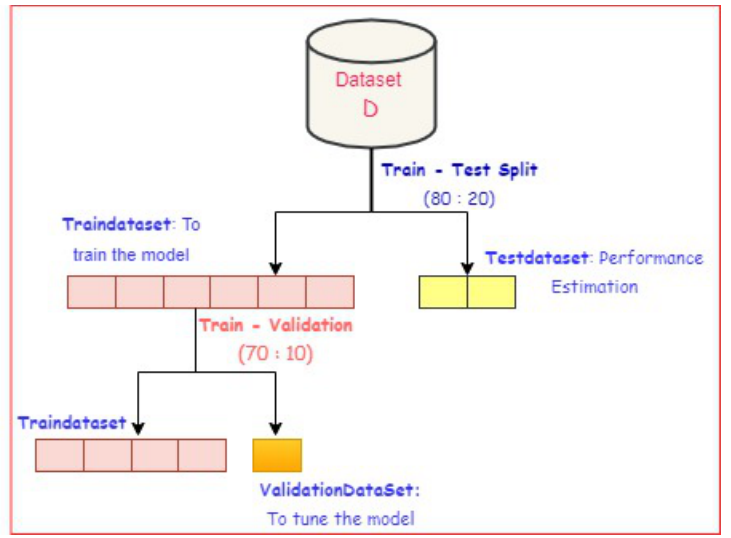
Figure 6. Dataset Split for Training, Validation and Testing.